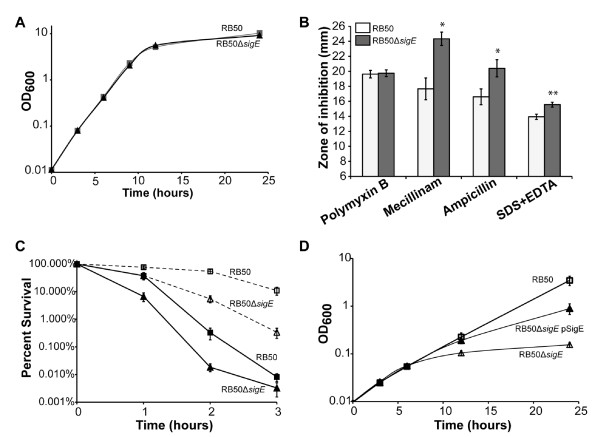
Role of SigE in response to environmental stresses. (A) RB50 (squares) and RB50ΔsigE (triangles) grow similarly at 37°C in Stainer-Scholte broth. (B) RB50ΔsigE (white bars) is more sensitive than RB50 (grey bars) to treatment with 100 μg mecillinam, 10 μg ampicillin, or 750 μg SDS and 2.9 μg EDTA, but is similarly sensitive to treatment with 300 IU polymyxin B in disk diffusion assays. The average diameters of the zones of inhibition ± SE from at least three independent experiments are shown. The disk diameter was 6 mm. The observed differences between the zones of inhibition for RB50 and the sigE mutant are statistically significant for mecillinam, ampicillin, and SDS-EDTA (* indicates a P-value of < 0.05; ** indicates a P-value < 0.01). (C) RB50ΔsigE (triangles) is more sensitive than RB50 (squares) to heat shock (solid line, filled symbols) caused by shifting cultures from 37°C to 50°C. RB50ΔsigE also exhibits reduced thermotolerance (dashed line, open symbols), surviving less well than RB50 when adapted first to 40°C before a shift to 50°C. The mean percent survival±SE of fifteen independent experiments for each strain is shown. (D) RB50ΔsigE containing the empty cloning vector pEV (open triangles) is more sensitive to treatment with 3% ethanol than RB50 pEV (squares). Expression of plasmid-encoded SigE (RB50ΔsigE pSigE) restores growth in 3% ethanol (filled triangles) to near wild-type levels at the 6 and 12 hour time points and partially restores growth at the 24 hour time point. The mean OD600 ± SE of at least four independent experiments is shown for each strain.